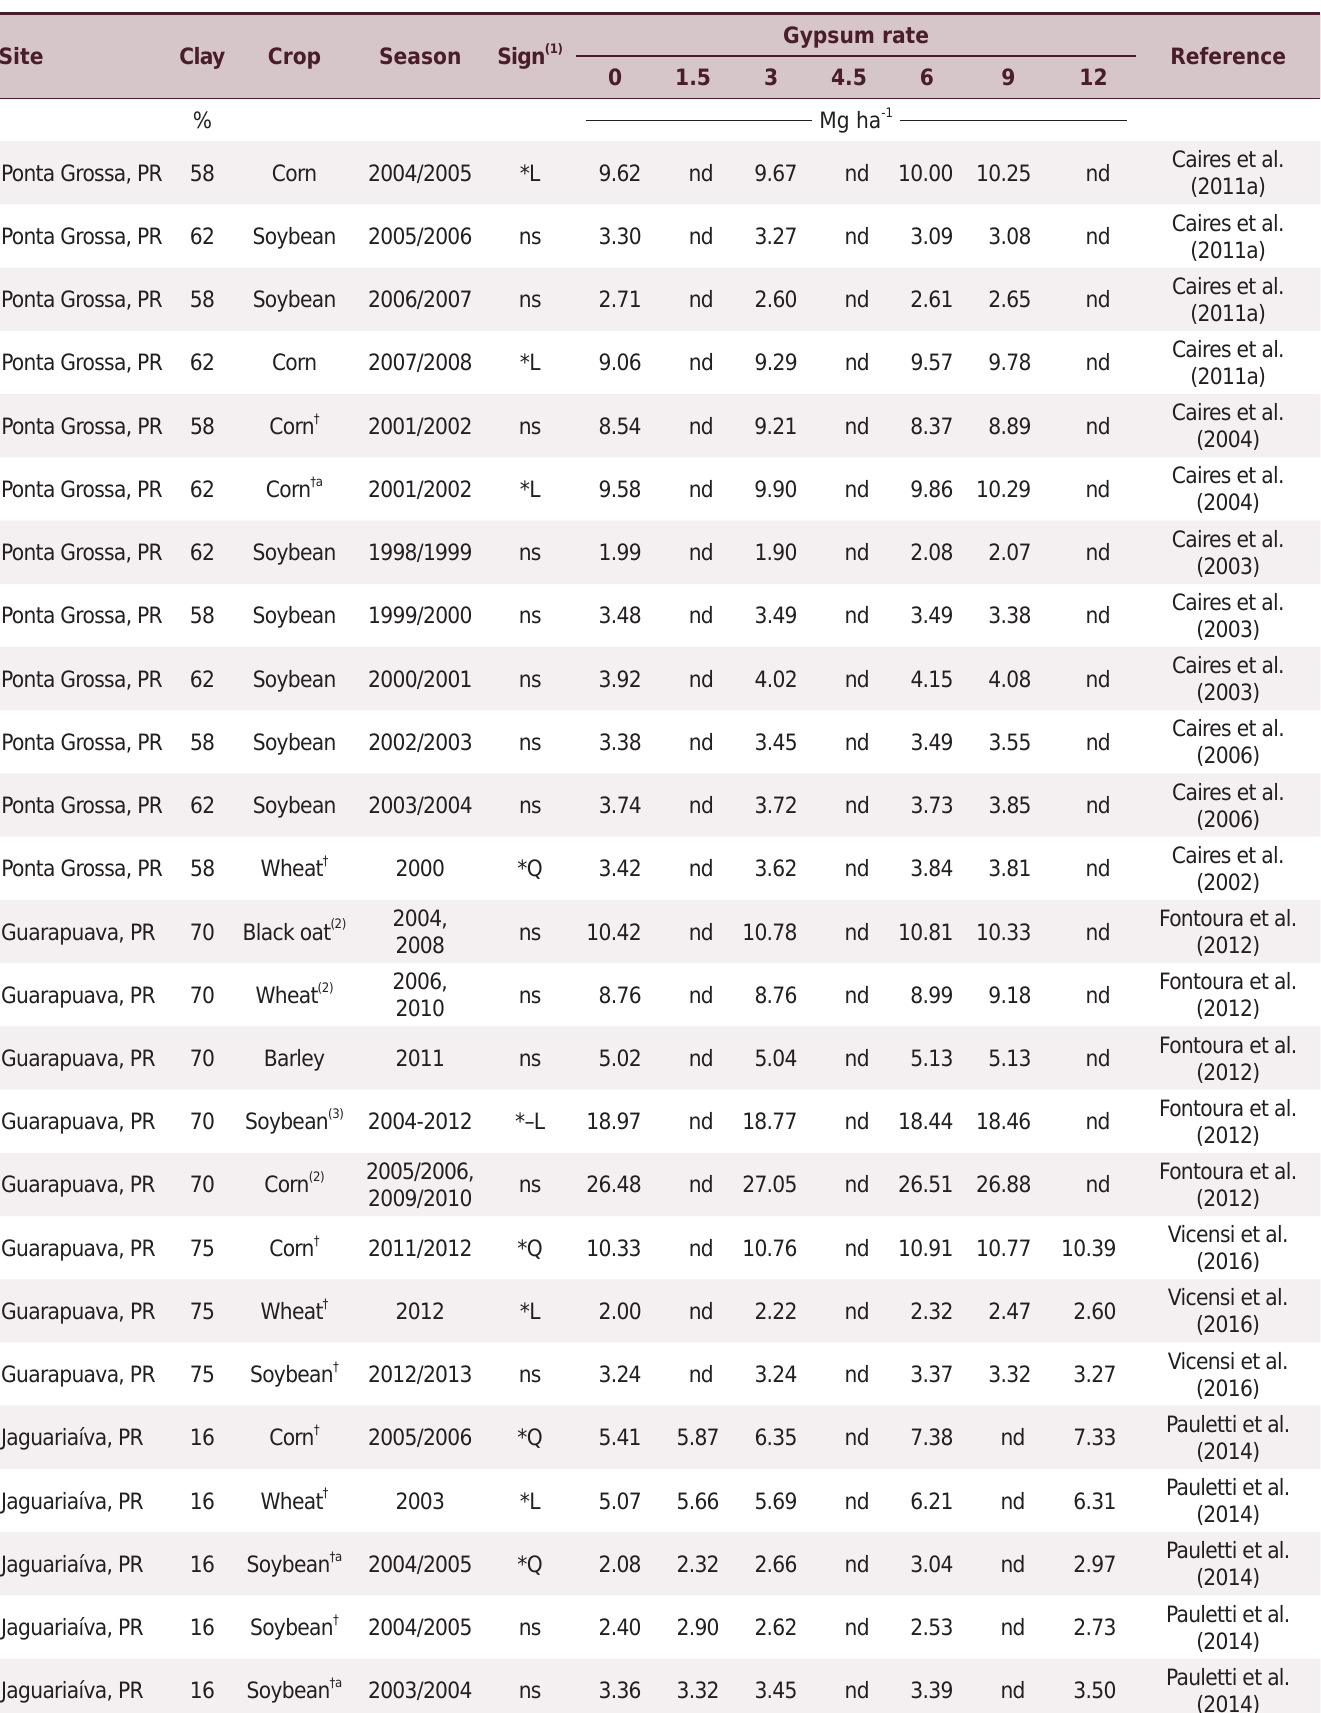
Table 1. Grain yield (Mg ha -1 ) of crops as a function of gypsum rates applied to subtropical soils under no-tillage in South of Brazil